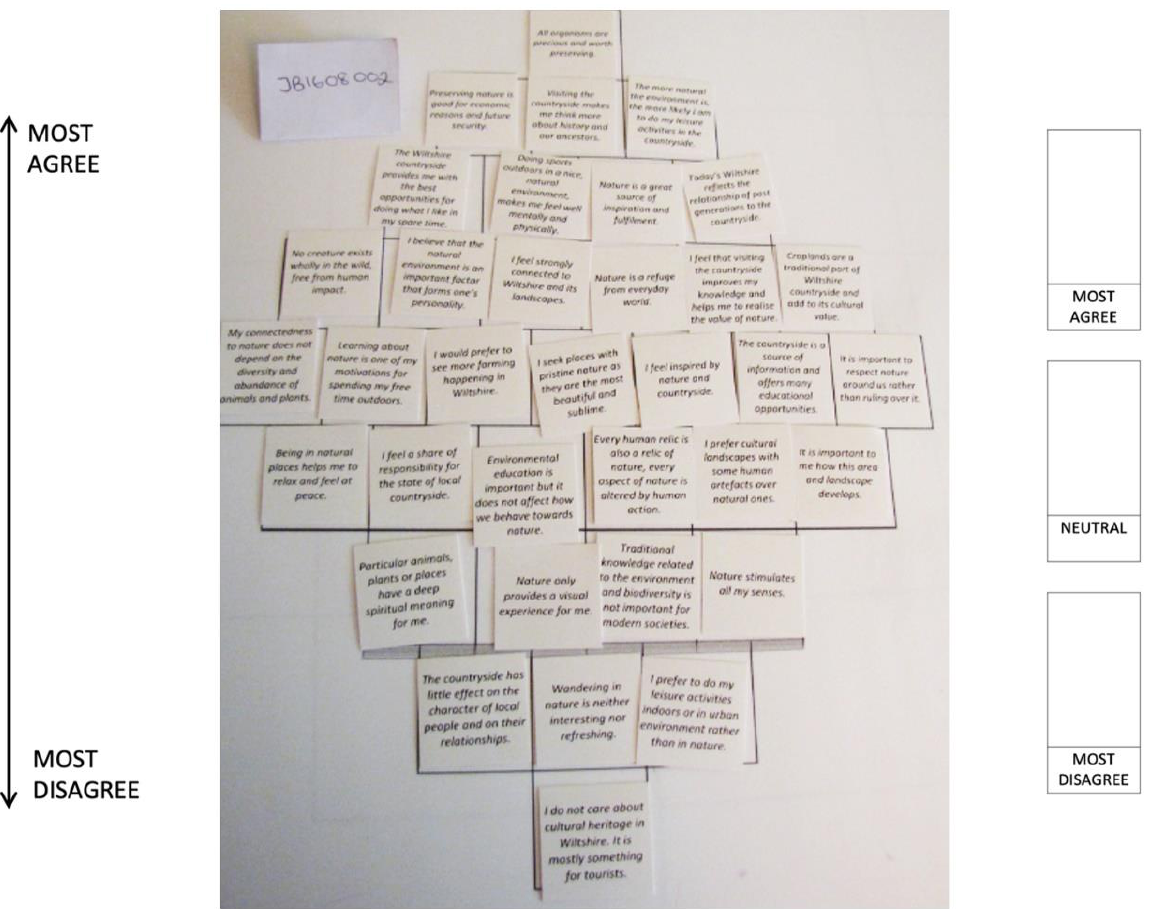
Figure 2. Example of the use of the Q sort template for sorting the 35 Q sort statements during interviews with respondents in Wiltshire. interviews with respondents in